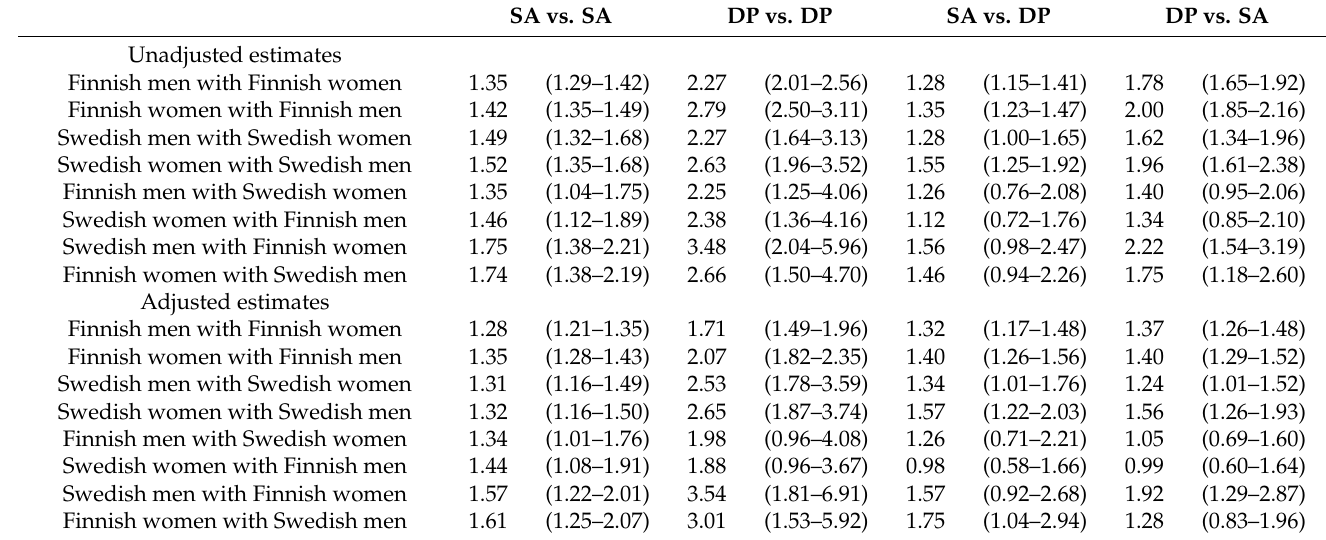
Table 2. Risk of benefit receipt in relation to partner’s receipt, by type of benefit, sex of the study person and ethnolinguistic composition of the household, unadjusted and adjusted estimates. SA vs. SA DP vs.